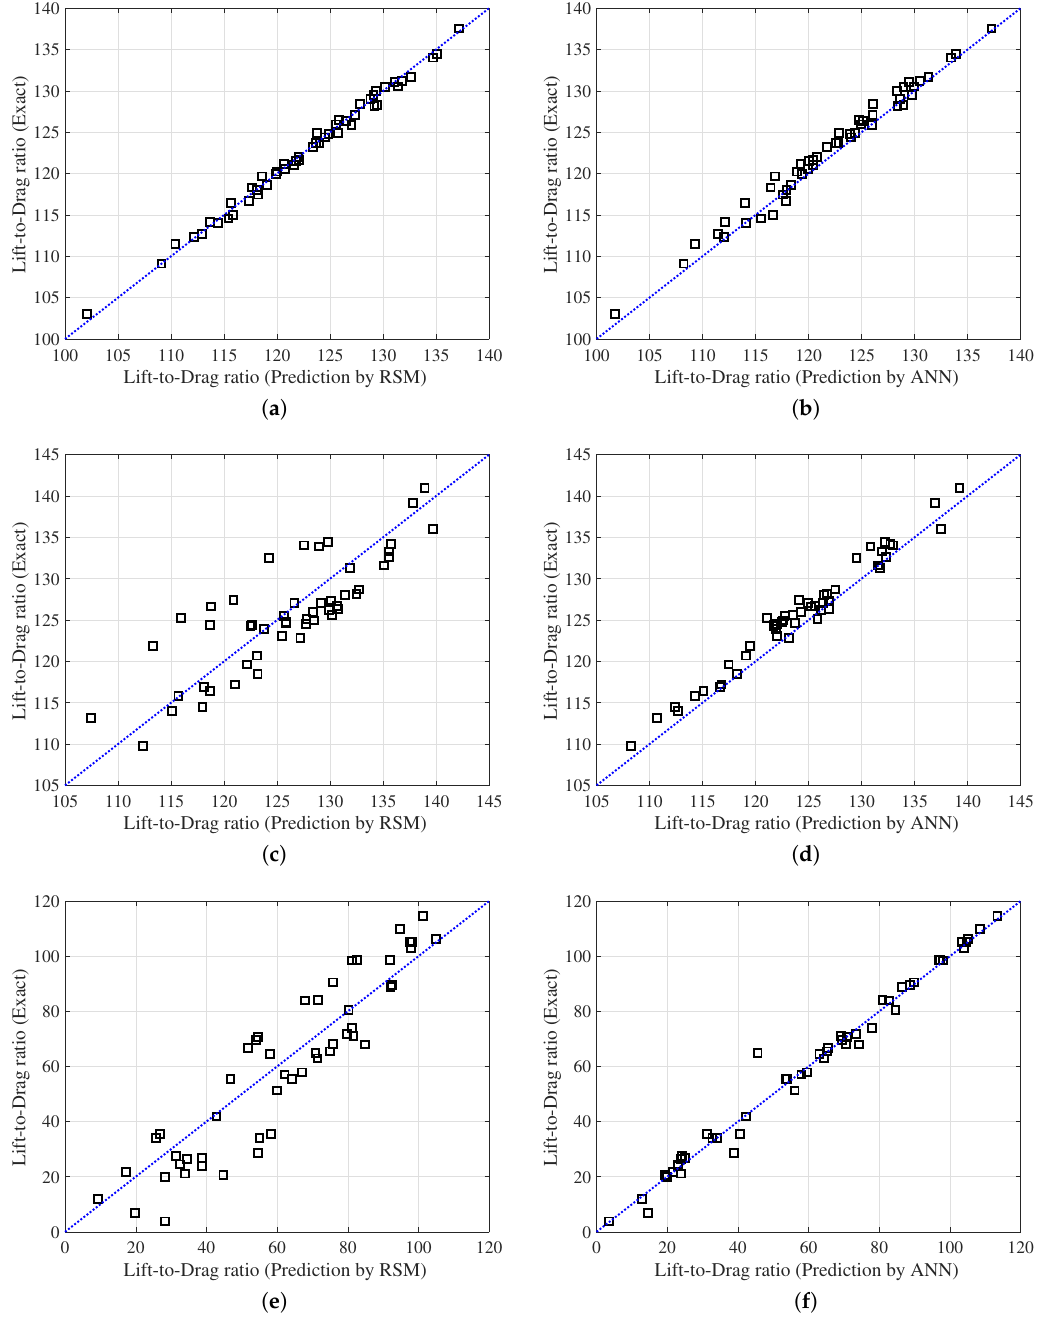
Figure 4. The accuracy comparison of the surrogate models computed from the RSM and ANN with the 50 test samples. The values for the lift-to-drag ratio of the 50 test samples computed from XFOIL (dealt as the exact value) and surrogate models are presented. The figures on the left and right columns show the values computed from the RSM-based and ANN-based surrogate models, respectively. The surrogate models presented in the first, middle, and last rows are created with G-DLB-4-3, G-DLB-8-3, and O-DLB-6-4,